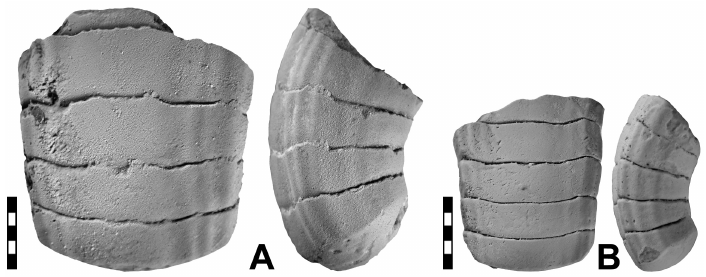
Fig. 16. Vestinautilus papilio sp. nov. from Oued Temertasset (both Korn et al . 2002 Coll.). A .